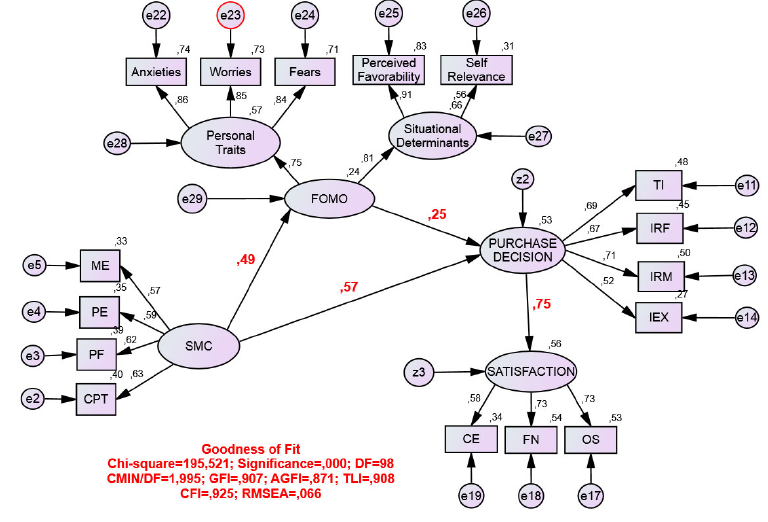
Fig. 4. Structural Equation